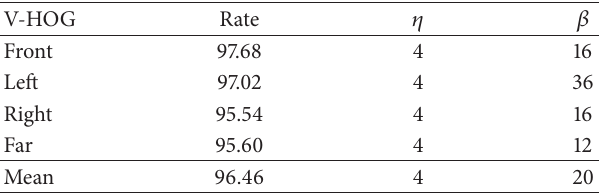
Table 2: Best accuracy results of V-HOG for each image region and their associated parameters ( 𝜂,𝛽